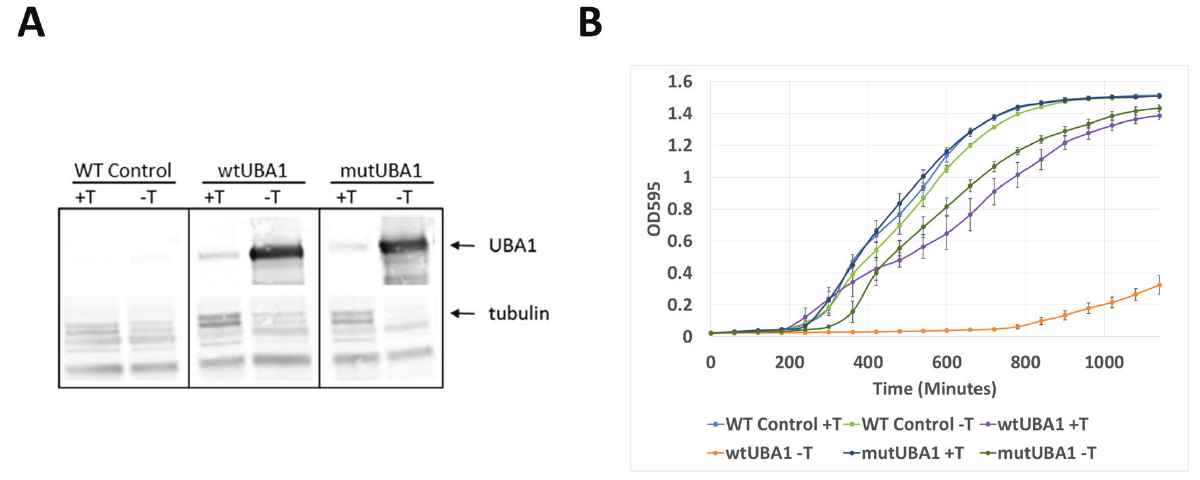
Figure 2. Construction of S. pombe strains integrated with human UBA1 . Wildtype and mutant forms of UBA1 were integrated into fission yeast under the control of the nmt1 thiamine-repressible promoter. ( A ) Western blot analysis of protein expression levels shows that both forms of UBA1 (wildtype and mutant) are expressed to equivalent levels. ( B ) Expression of wild-type UBA1 inhibits S. pombe cell